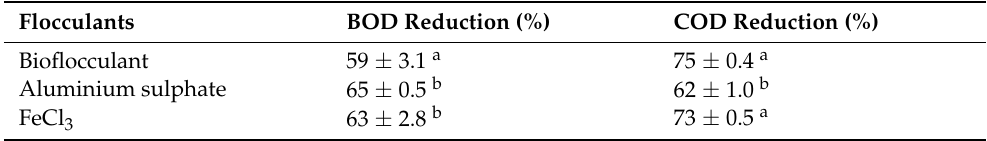
Table 5. Mine wastewater treatment by the